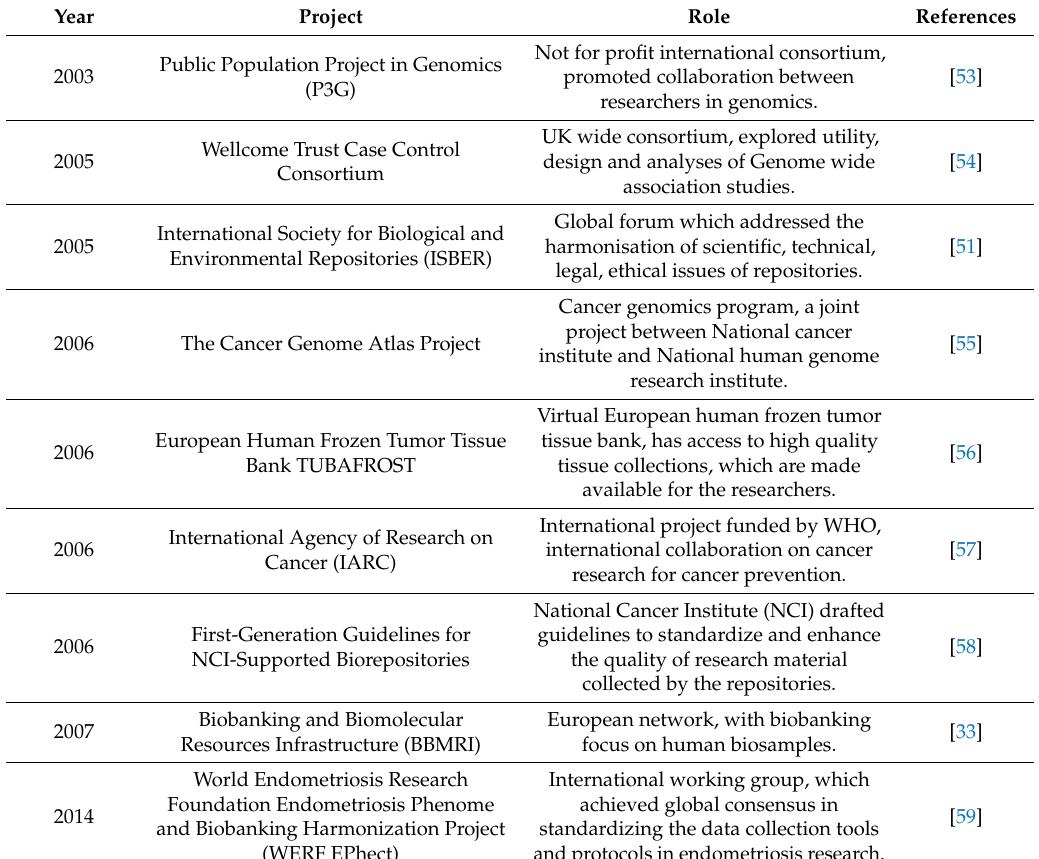
Table 1. List of International and National E ff orts of Harmonization of